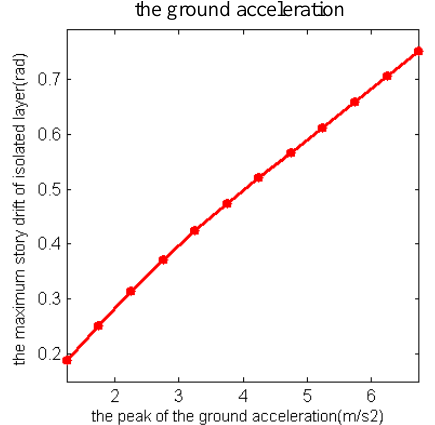
Fig.7b The maximum story drift of isolated layer as function of the magnitude of the ground